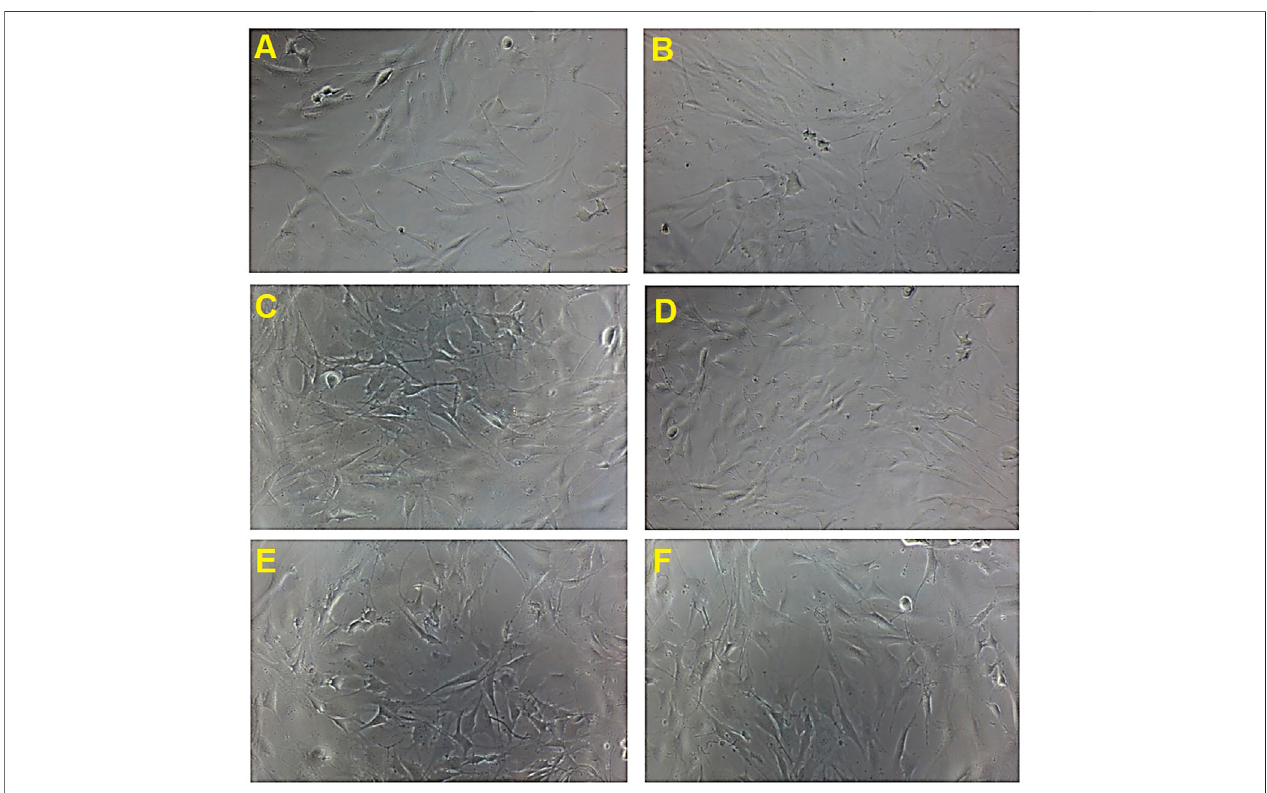
FIGURE 4 | Cell proliferation activity and morphological changes in MC3T3-E1 cells treated with B. acmella extracts. (A) : Control (untreated cells); (B) : Positive control(Clodronate); (C) :BaE_2.93( Ba Eat2.93 µg/ml), (D) :BaE_23.44( Ba Eat23.44 µg/ml), (E) :BaA_5.86( Ba Aat5.86 µg/ml)and (F) :BaA_11.72( Ba Aat11.72 µg/ ml) at Day 1 compared to control (untreated cells) at 100x magni fi cation.